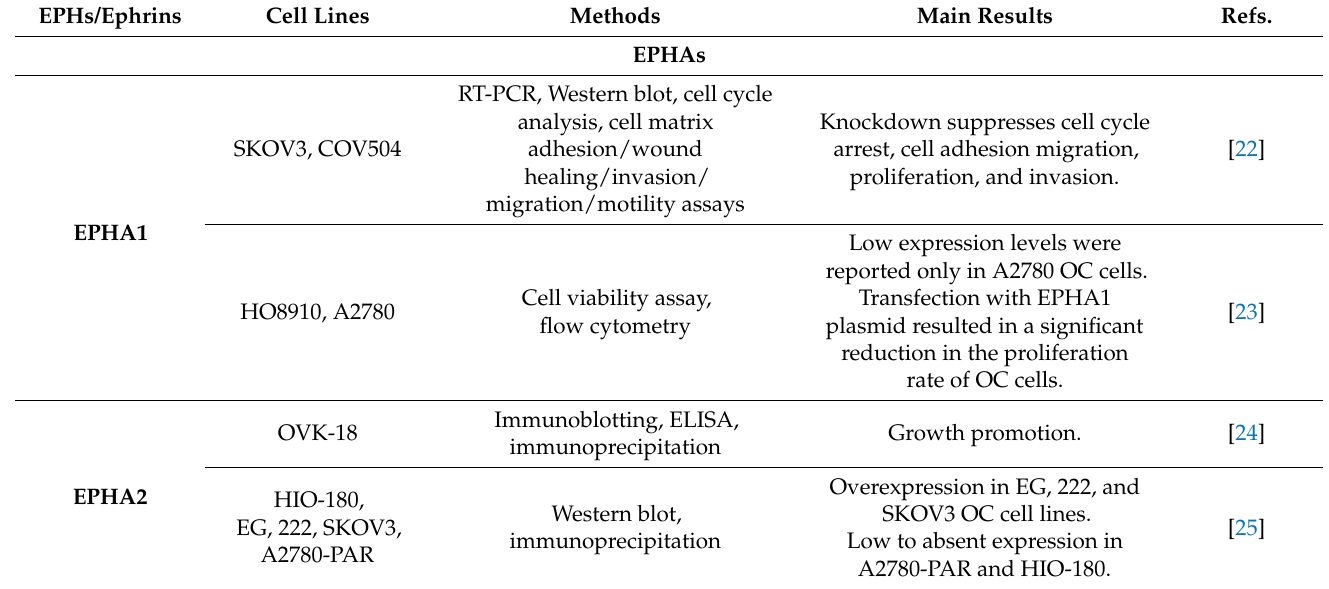
Table 2. The role of the EPH/ephrin system in OC cell lines and human